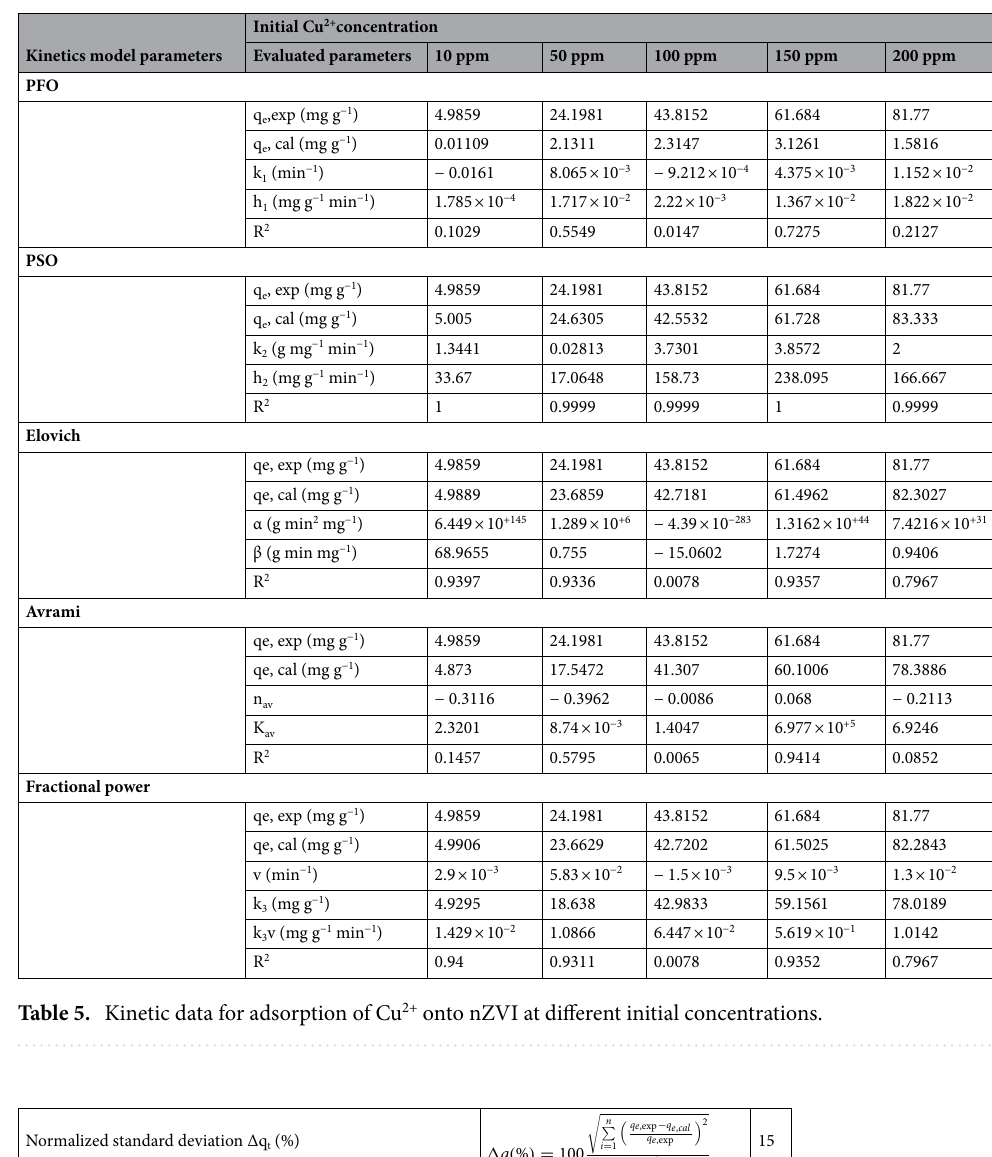
Normalized standard deviation Δq t (%) Hybrid fractional error function (HYBRID)